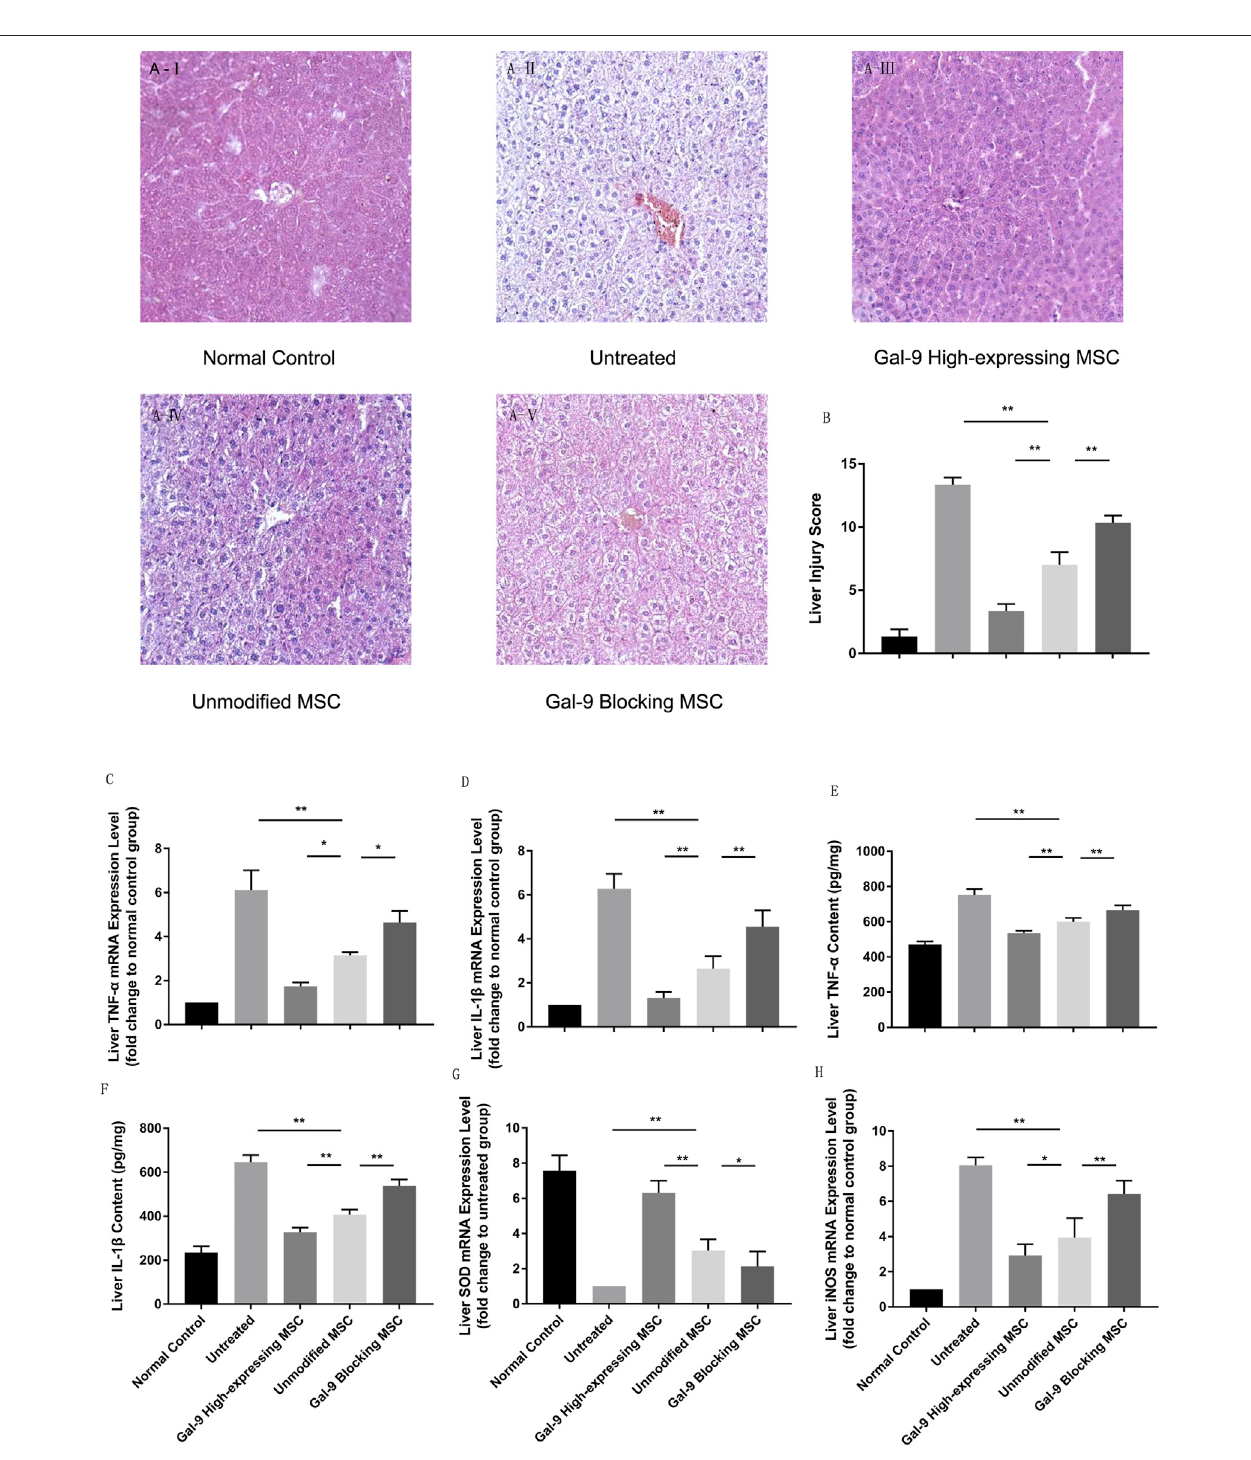
FIGURE 4 | Gal-9 mediates MSC-based therapy in attenuating hepatic damage. (A) Photomicrographs of representative histological sections (H&E staining, original 100 × magni fi cation) of liver in each group. (B) Liver injury score. Double-blind reviewing was evaluated by the following criteria: necrosis, sinus congestion and edema, lipid vacuoles and in fi ltration of hyperemia, and in fl ammatory cells (0 – 4, total: 0 – 16). (C) Liver TNF- α mRNA expression level. (D) Liver IL-1 β mRNA expression level. (E) TNF- α protein concentration in liver homogenate. (F) IL-1 β protein concentration in liver homogenate. (G) Liver SOD mRNA expression level. (H) Liver iNOS mRNAexpression level.Datavariance wasassessed byusing one-wayanalysisofvariance (ANOVA), followed by leastsigni fi cantdifference (LSD) test, n =6. * p < 0.05, and ** p < 0.01. Abbreviations: iNOS, inducible nitric oxide synthase; SOD, superoxide dismutase.